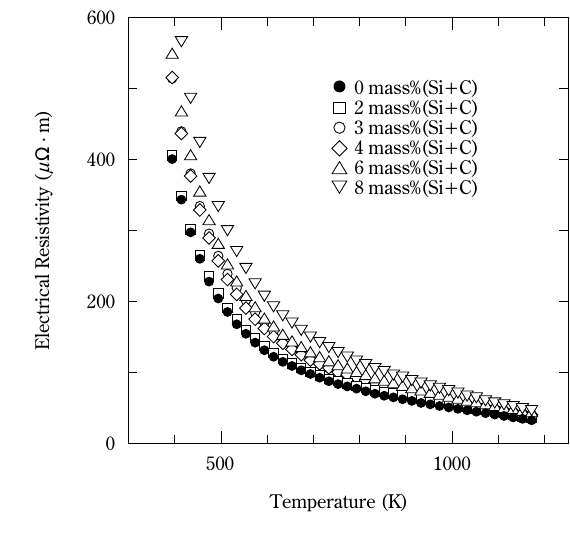
Fig. 5 Temperature dependence of the electrical resistivity for the sintered p-type Fe 0.92 Mn 0.08 Si 2 with addition of x mass% (Si (cid:4) C).